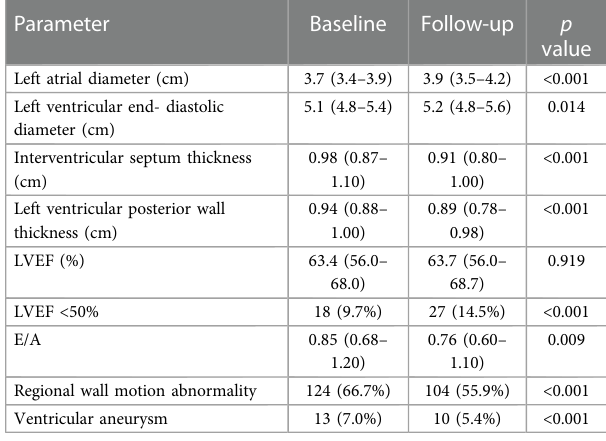
TABLE 3 Baseline clinical characteristics according to improvement in left ventricular ejection fraction